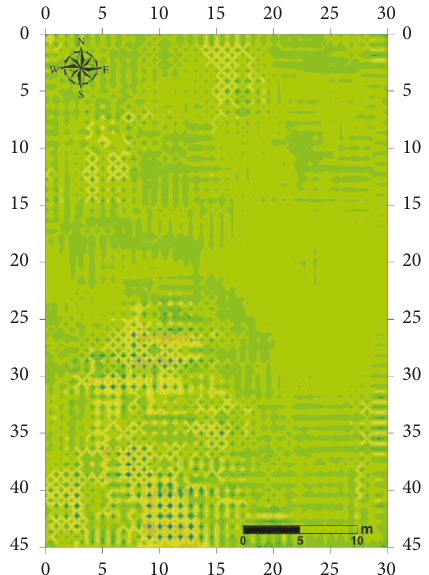
Figure 6: Response of the magnetic data downward continued to